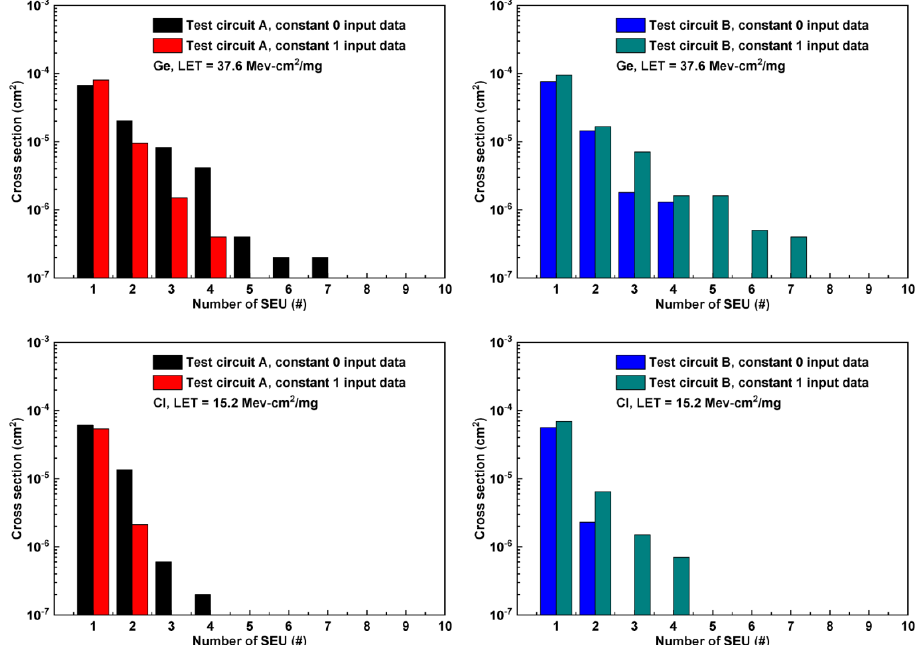
Figure 6. Measured results with different LET values. Test circuit A and B have the normal connec- tions of target